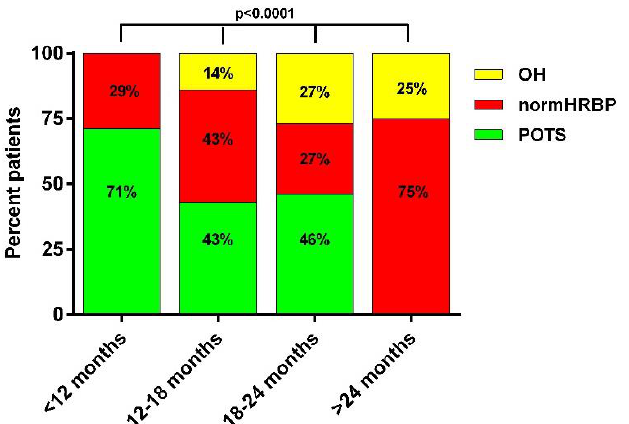
Figure 1. Frequencies of hemodynamic tilt test results in long-haul COVID-19 patients: relation with disease duration. OH: orthostatic hypotension; normHRBP: normal heart rate and blood pressure response; POTS: postural orthostatic tachycardia syndrome.